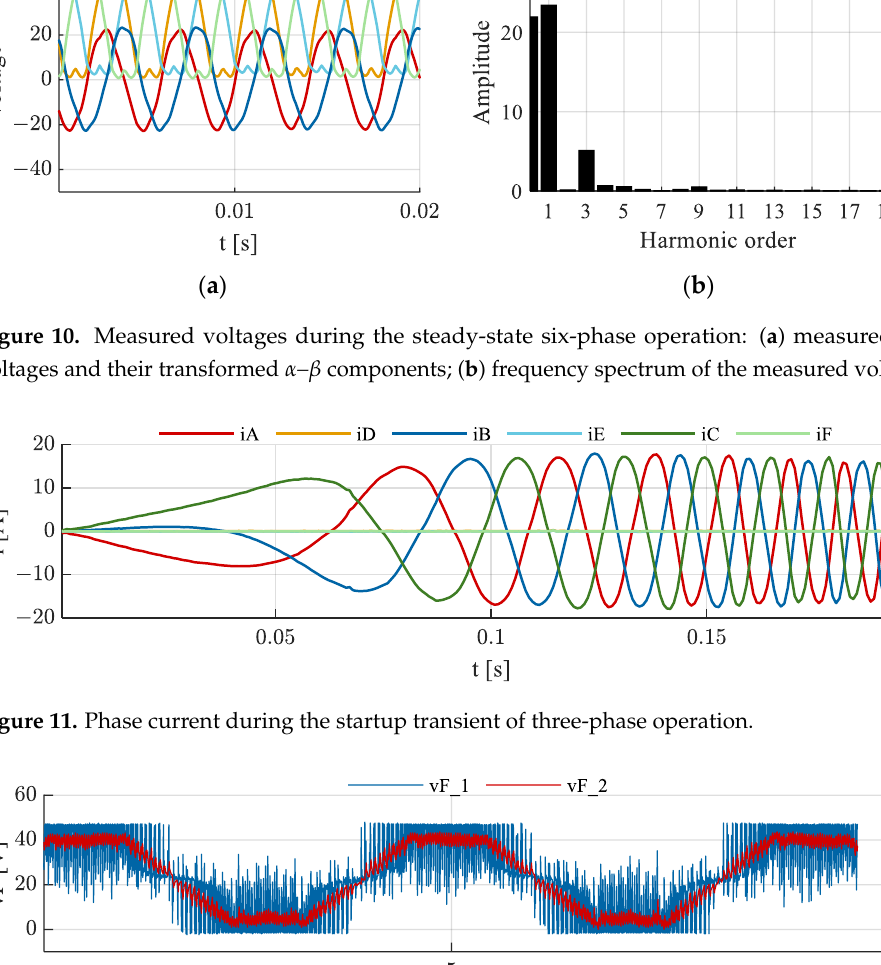
Figure 9. Oscilloscopic record of the measured voltage during the steady-state six-phase operation.